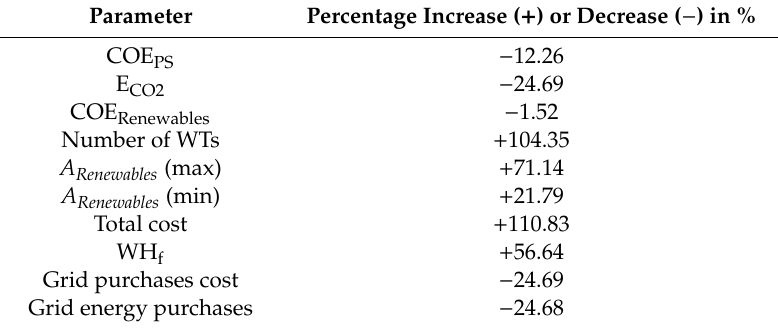
Table 6. On-grid wind farm with / without PHS